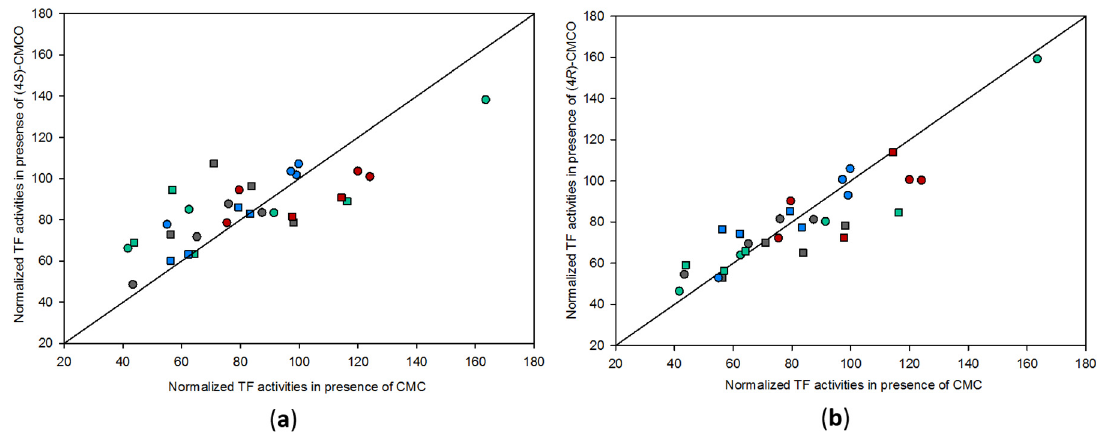
Figure 11. Summarized correlations between effects of: ( a ) CMC and (4 S )-CMCO; ( b ) CMC and (4 R )-CMCO on activation of the four transcription factors in A549 (squares) and BEAS-2B (circles) cells, as shown in Figures 7–10. Data points depicted below the diagonals signify stronger inhibitory effects displayed by CMCO as compared to CMC. Color codes for the stressors: grey—CSE, green—HQ; blue—H 2 O 2 , red—TNF.